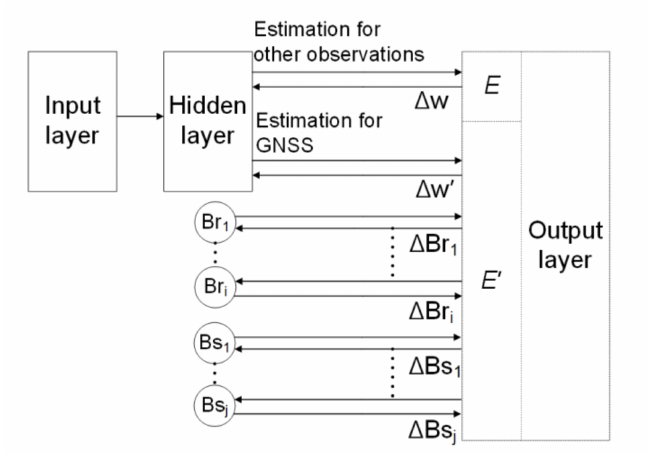
Figure 5. The diagram of a residual minimization training neural network for CIT (adapted from [11]). The input nodes are the intercepts in voxels calculated by the coordinates of the satellites and receivers. The output nodes are the IED utilized to obtain the estimated observations, which are updated with the weights. The weights and the instrumental biases are adjusted by the objective